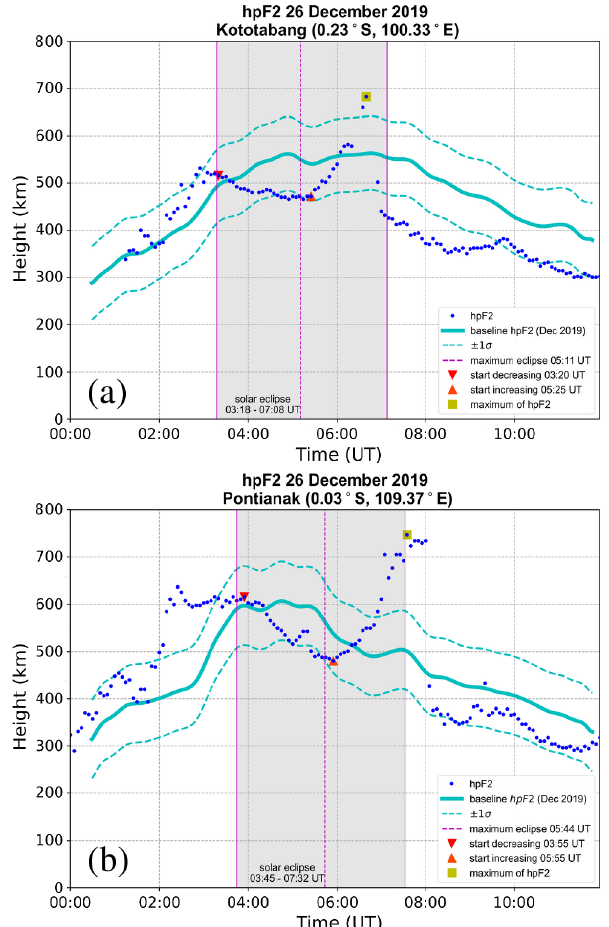
Figure 7. Time series plots of ionospheric height with maximum electron density ( hp F2) from scaling of ionosonde measurements at (a) Kototabang and (b) Pontianak on 26 December 2019. Observa- tion data are shown in blue, the baseline hp F2 level based on De- cember 2019 averages is shown as cyan curves, and the solar eclipse period is indicated with gray bands.